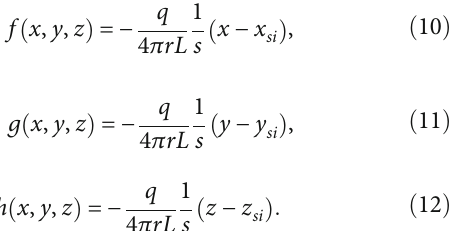
1 ffiffiffiffiffiffiffiffiffiffiffiffiffiffiffiffiffiffiffiffiffiffiffiffiffi